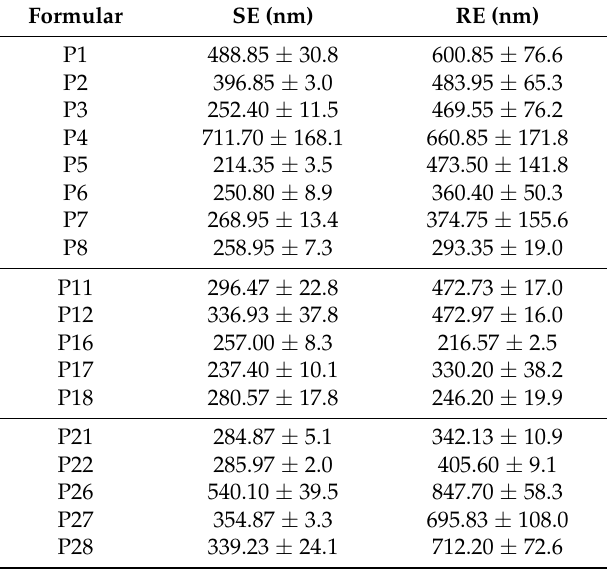
Table 1. The particle size of second emulsion (SE) before spray drying and reconstituted emulsion (RE) of olive oil powder after spray drying (n =